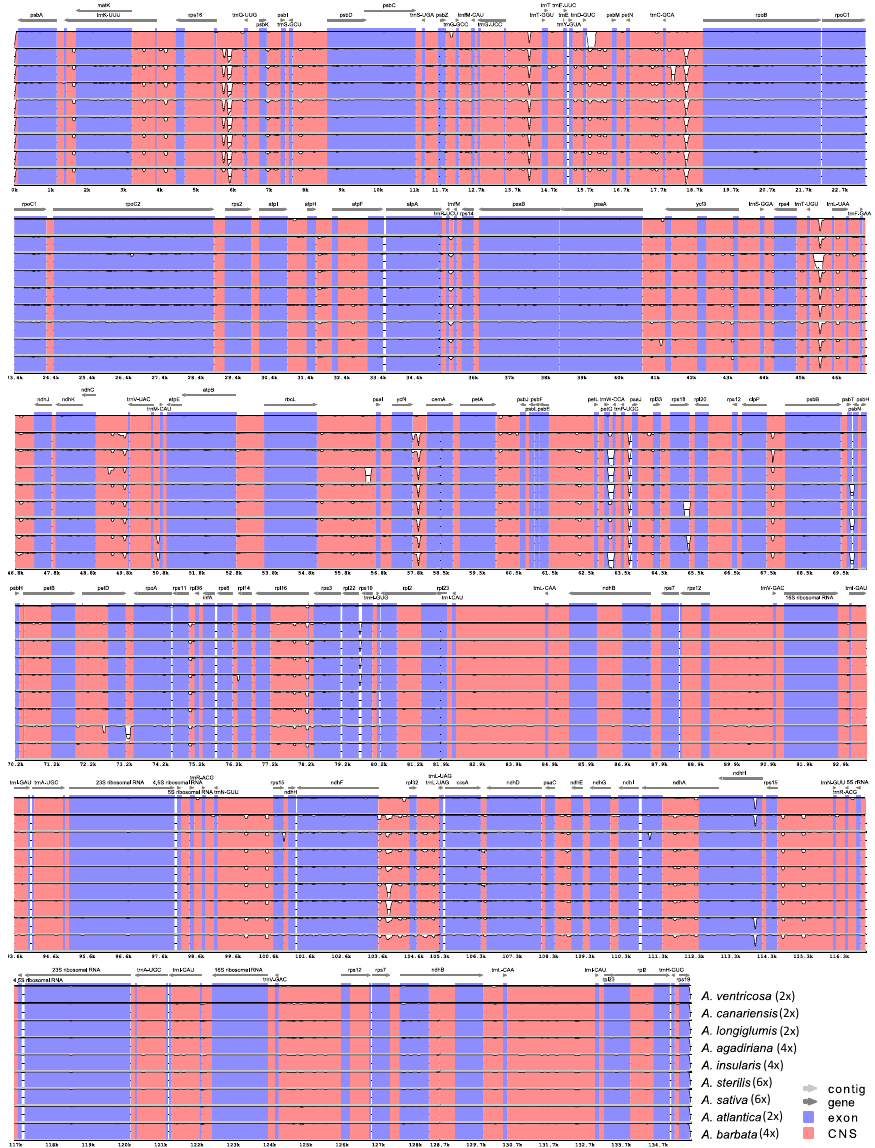
Figure 2. Percent identity plot by mVISTA of nine Avena chloroplast genome assemblies representing four diploid, three tetraploid, and two hexaploid Avena species, using A. eriantha as reference. Vertical scale indicates the percentage of identity ranging from 98.385% to 99.377%. Coding regions are in blue and non-coding regions are in orange.